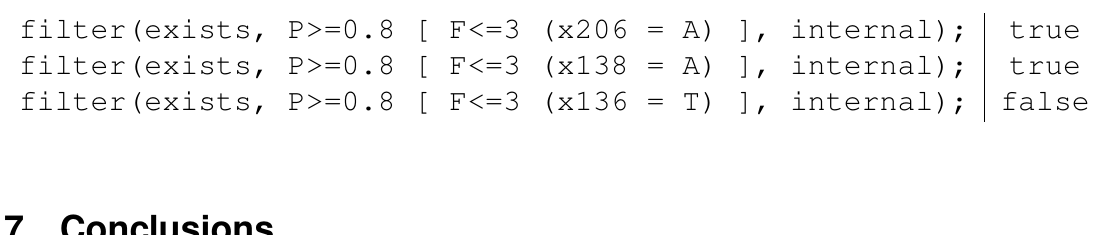
Table 2: Formulas evaluated over the phylogenetic tree using PRISM and the output result of the